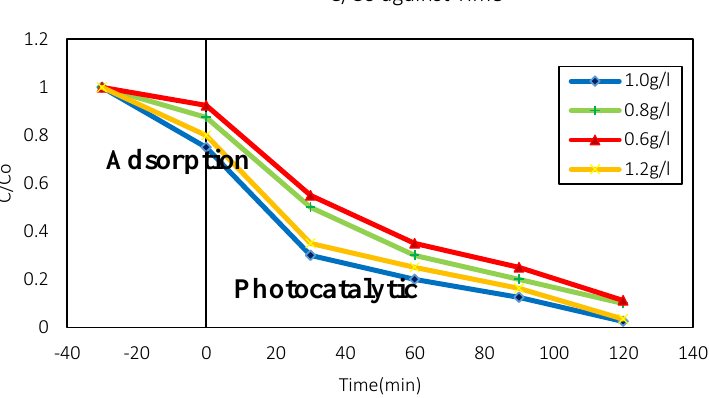
Figure 4: Effect of catalyst on LaFeO3 of adsorption and photocatalytic degradation HA (pH = 6, HA = 10 mg/L, contact time = 120